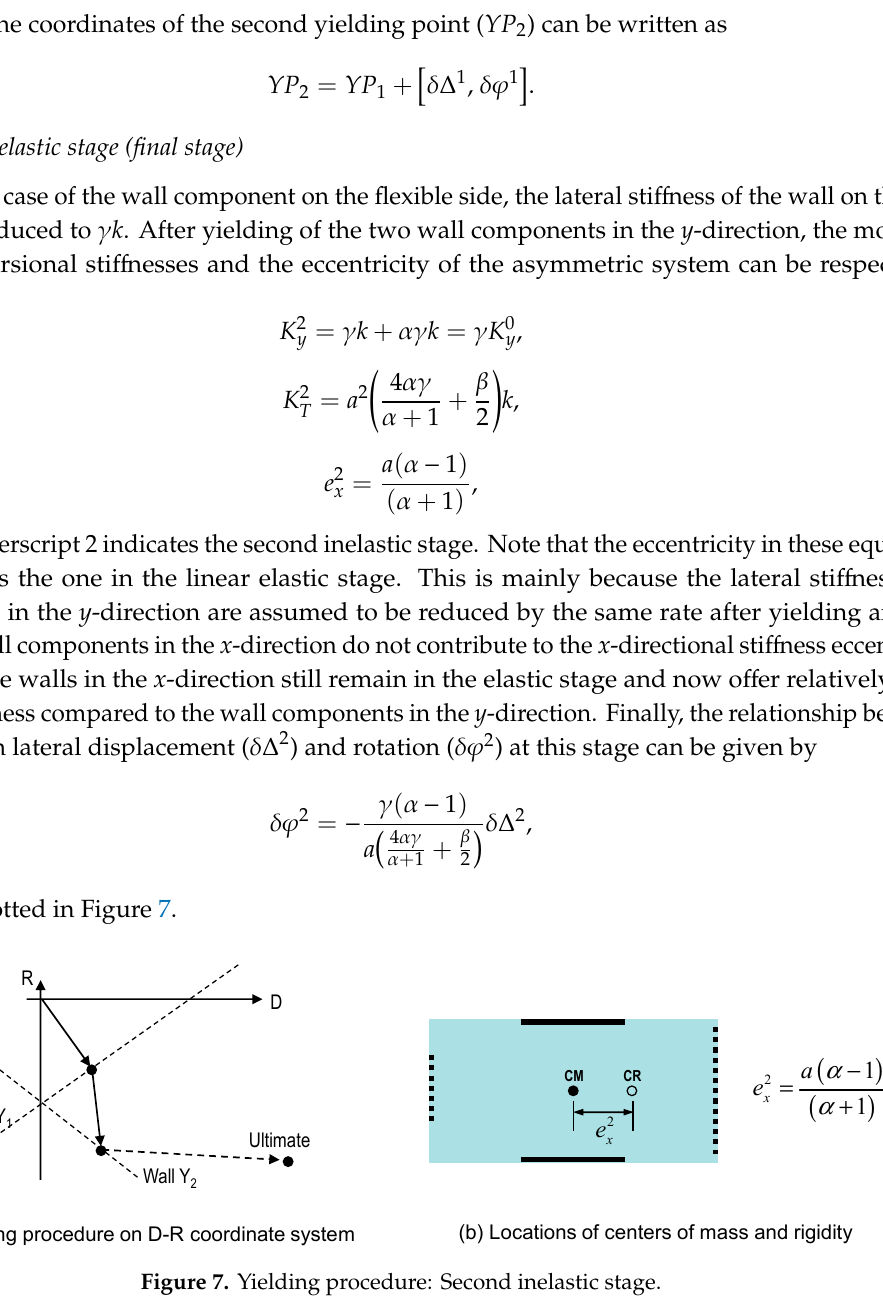
Figure 6. Yielding procedure: First inelastic stage.